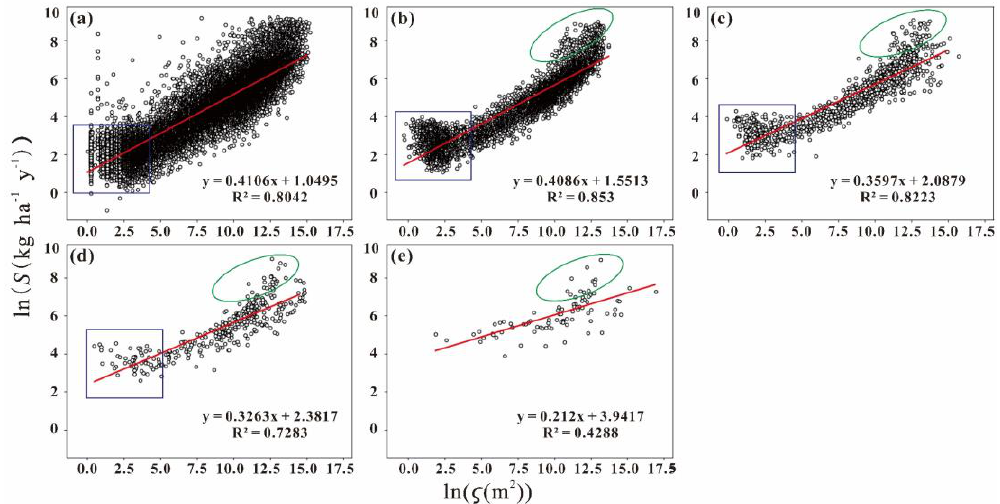
Figure 9. Fitting relationship between scale effect index S and the sill value ς of the DEM semi-variogram: the spatial resolution is 10 km ( a ), 20 km ( b ), 40 km ( c ), 80 km ( d ), and 160 km ( e ). ln( ς ), natural logarithmic function.